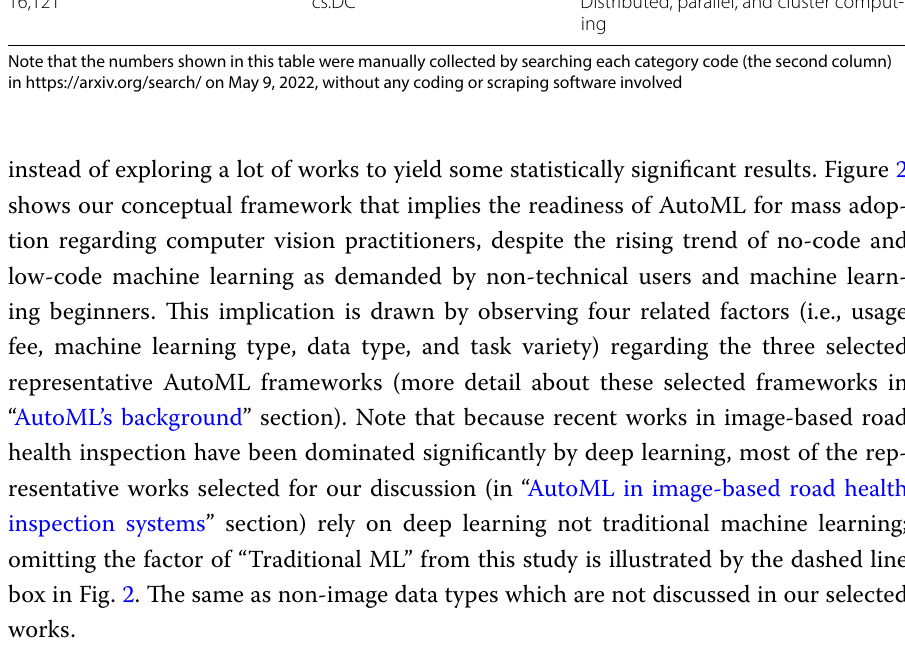
Note that the numbers shown in this table were manually collected by searching each category code (the second column) in https://arxiv.org/search/ on May 9, 2022, without any coding or scraping software involved